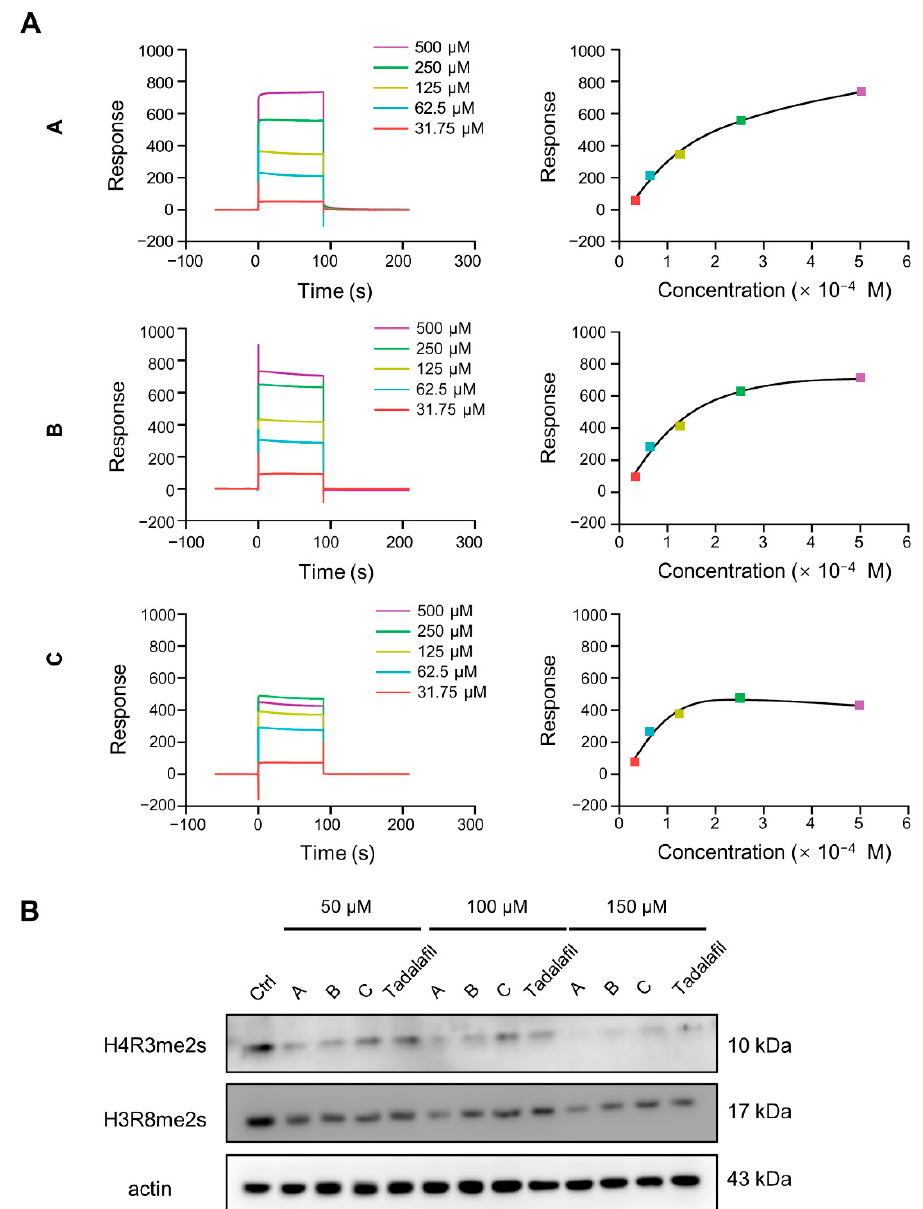
Figure 3. Chemicals A, B, and C bind to PRMT5 and inhibit histone arginine methylation. ( A ) Binding abilities of chemicals A, B, and C to the PRMT5/MEP50 complex detected by Biacore T200. ( B ) MDA-MB-231 cells were treated with the indicated concentrations of chemicals A, B, C, and tadalafil for 48 h, and the global protein levels of H4R3me2s and H3R8me2s were detected by immunoblotting. The picture is representative of two independent experiments.